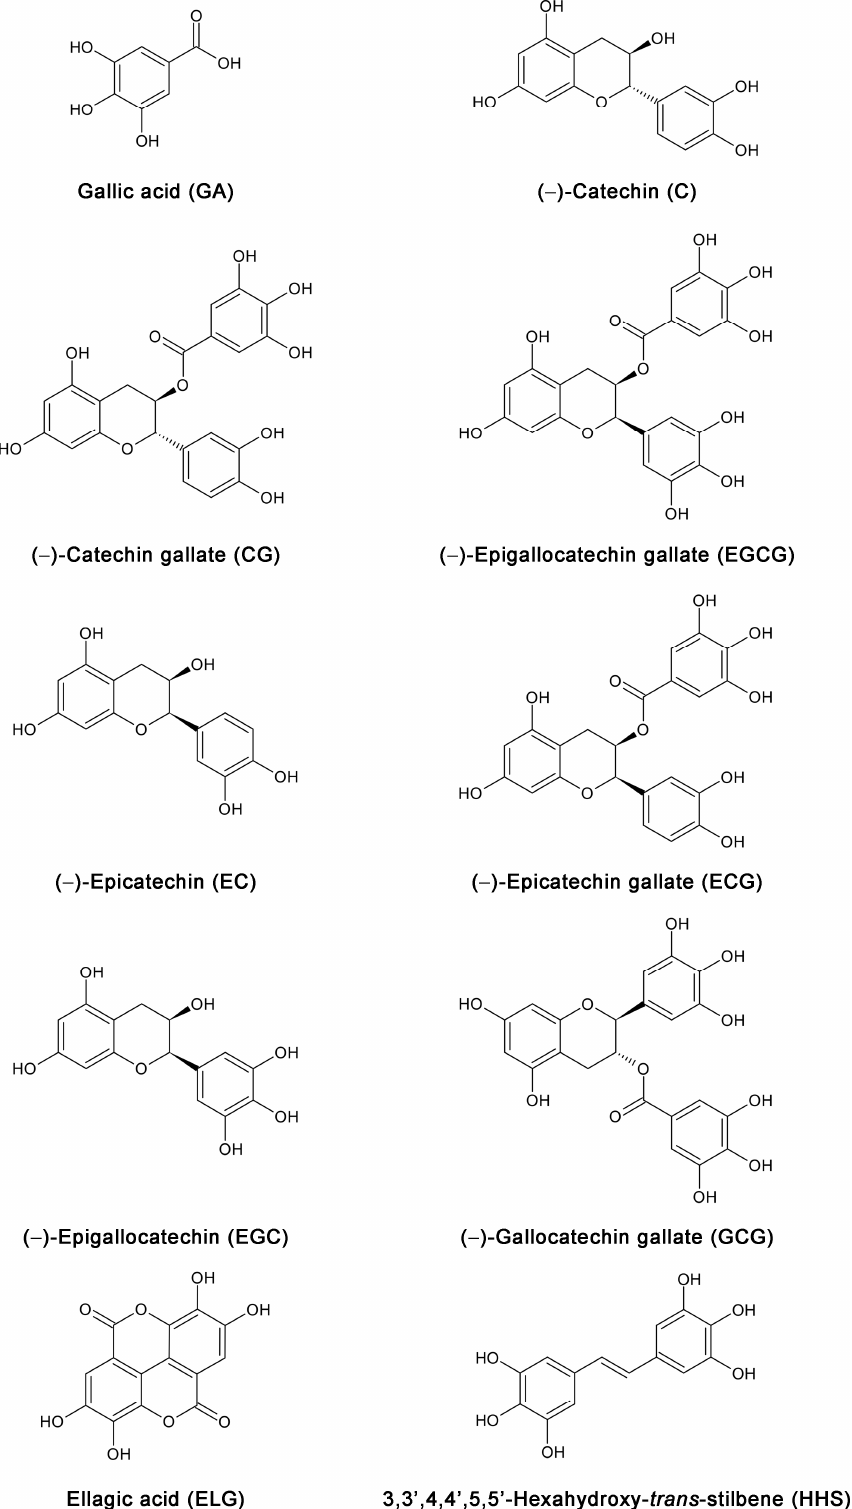
Figure 1. Chemical structures of the nine green tea constituents GA , C , CG , EGCG , EC , ECG , EGC , GCG , and ELG , as well as the synthetic hexahydroxy resveratrol analog HHS as a control compound, for structure–activity relationships.